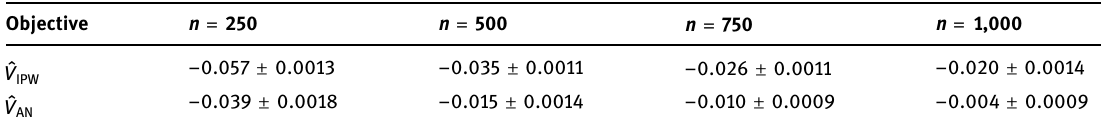
Table 2: Thresholds learned by V ˆ IPW and V ˆ AN for varying n for data generated according to ( 20 ) . Each entry is an average over 100,000 replications and standard errors are over 10 replications of the 100,000 trials. The optimal policy is to threshold at 0; minimizing V ˆ AN consistently learns better